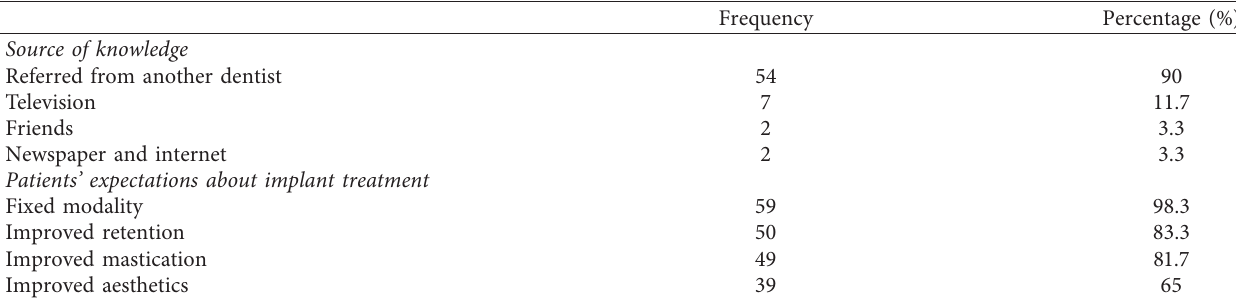
Table 2: Participants’ knowledge and expectations regarding basal implants.